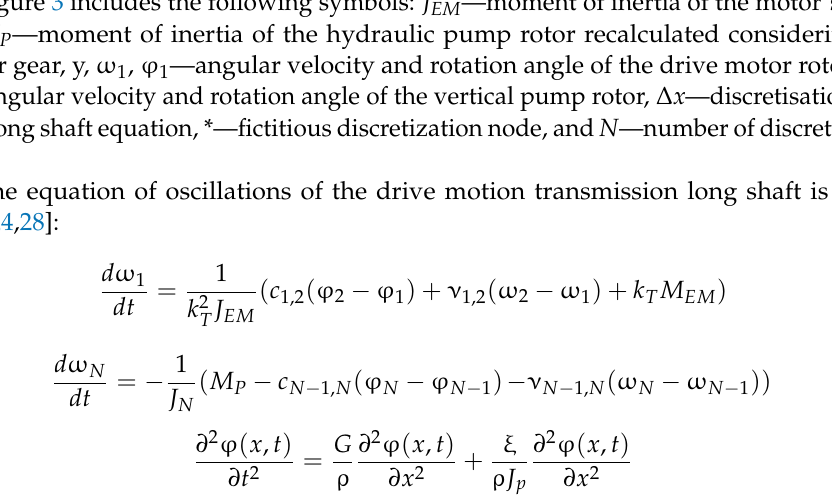
∆ x —discretisation step